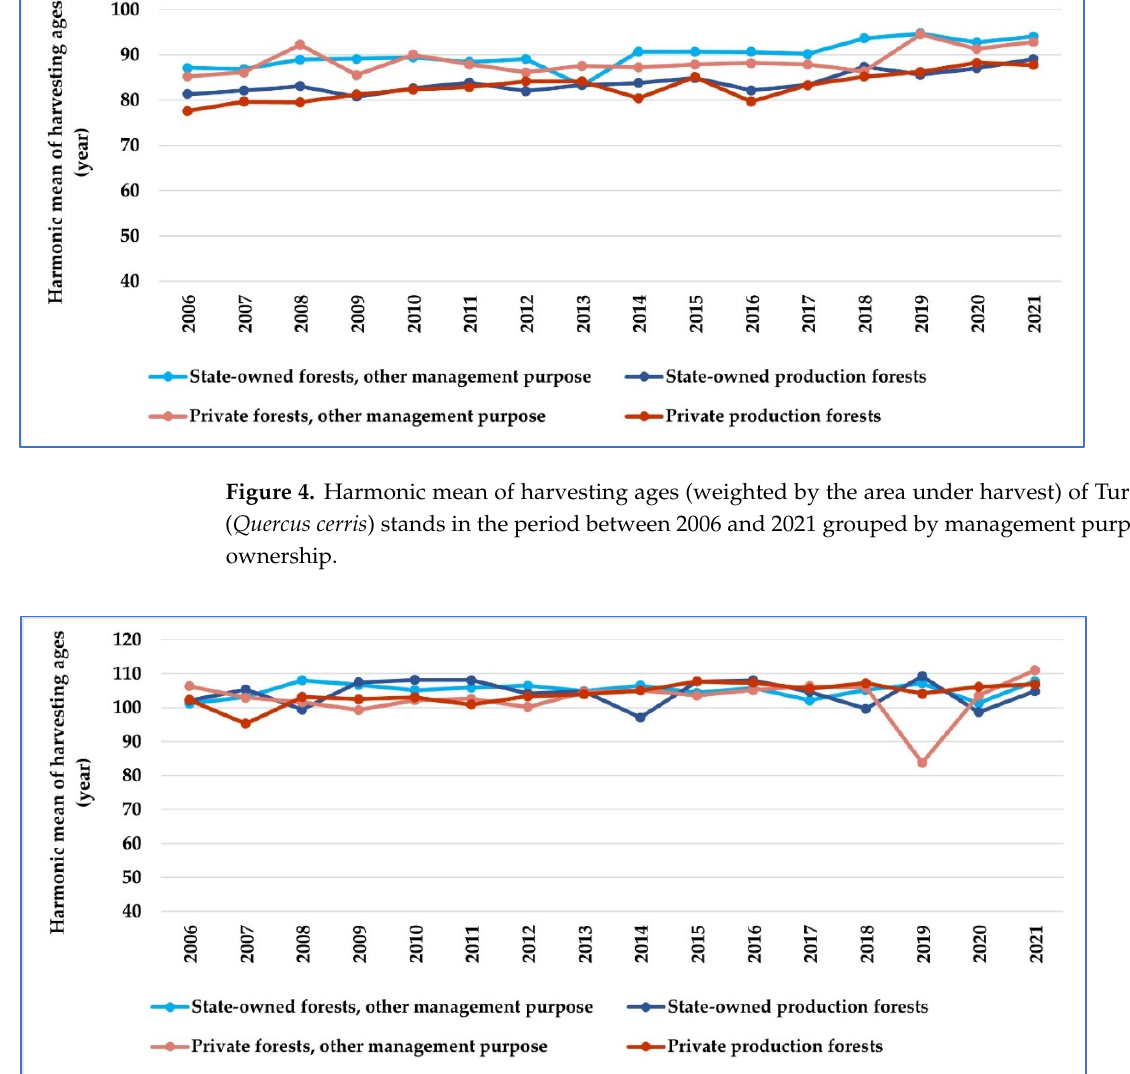
Figure 3. Values of the regression slope (parameter ‘a’) of the trendline of harvesting ages (where R 2 > 0.5) weighted by the area under harvest sorted in descending order and colored by management purpose and ownership. Negative ‘a’ values mean decreasing trend while positive values mean in- creasing trend. (SP: state-owned production forests; SO: state-owned forests with other manage-